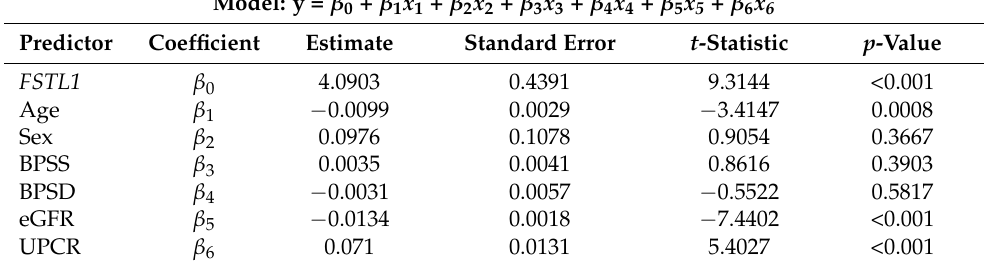
Table 3. Multiple linear regression analysis of FSTL1